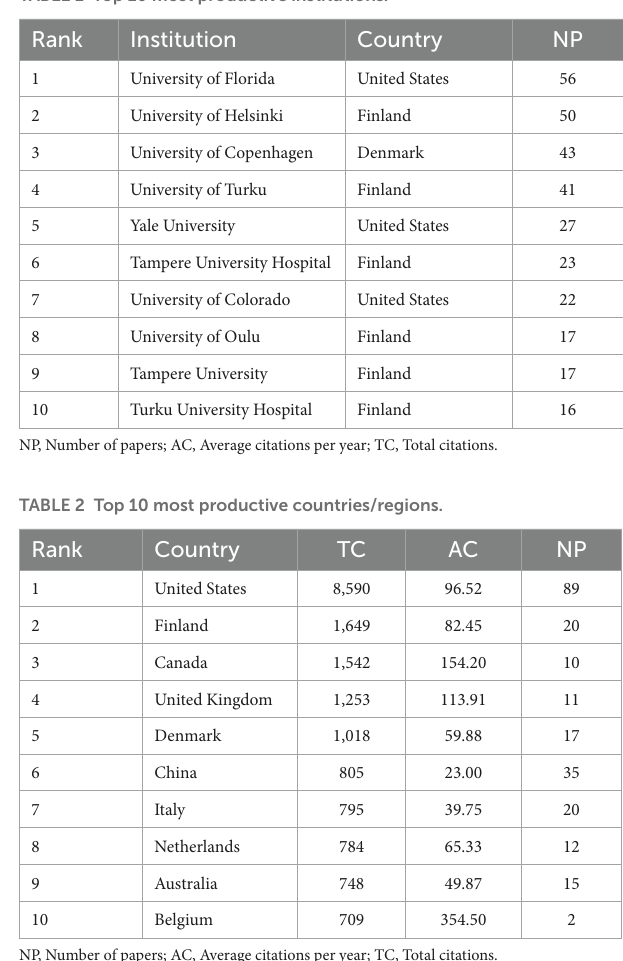
TABLE 1 Top 10 most productive institutions.